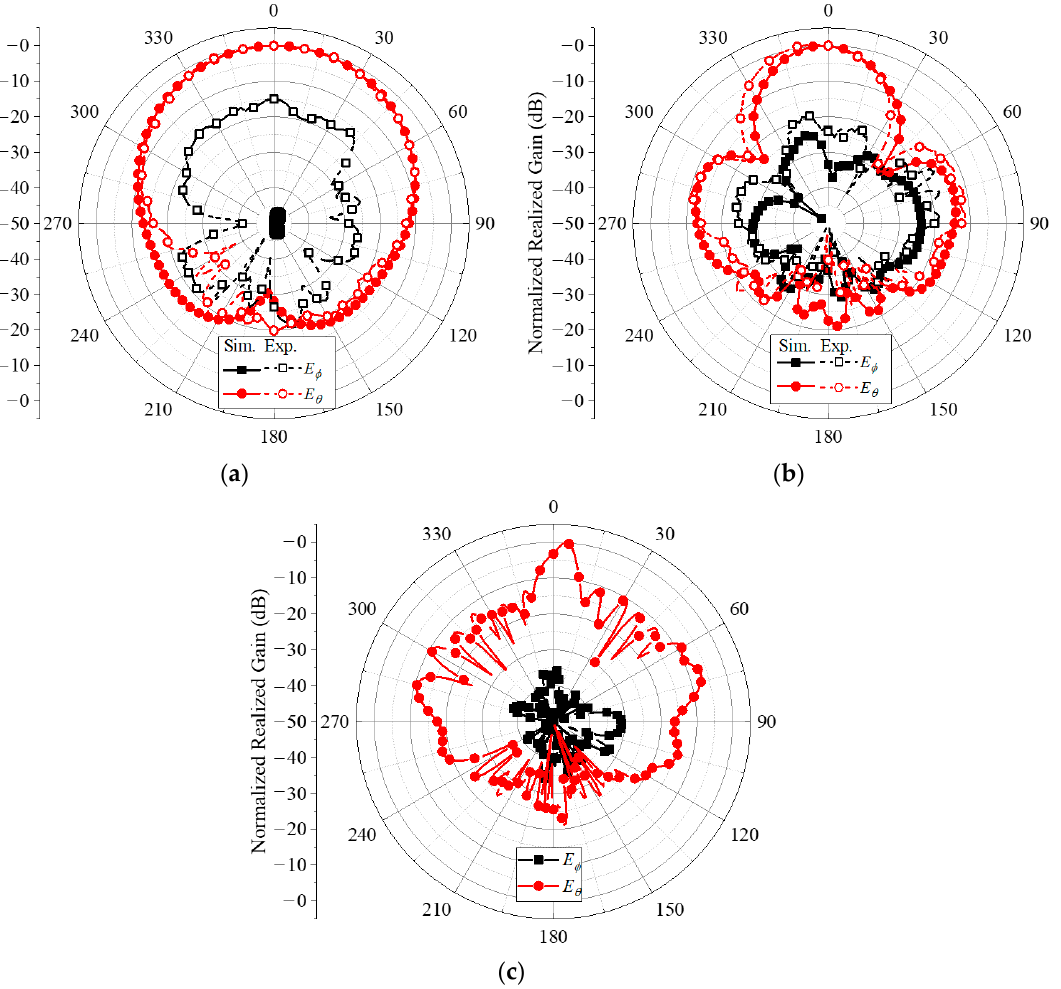
Figure 18. Simulated and measured radiation patterns at ( a ) 5.9, ( b ) 28, and ( c ) 145.5 GHz.